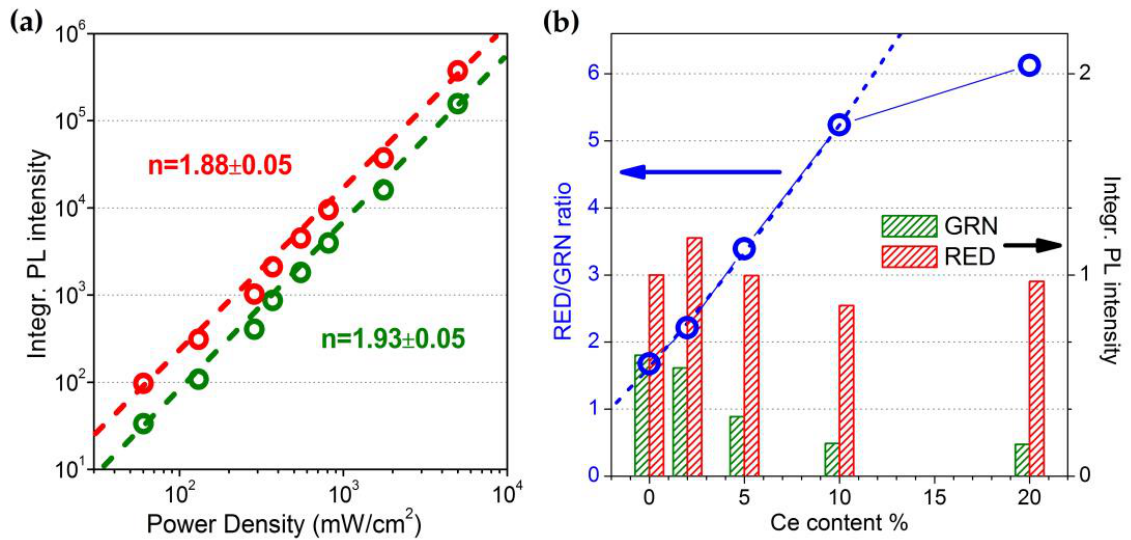
Figure 4. ( a ) Log – log plot of the integrated UCPL intensity of GRN and RED emissions vs. 980 nm pumping power density; the order n of the UC processes corresponds to the slope of the linear fit (dashed lines) of the experimental data; the measurements were performed on Ce_10 sample. ( b ) Bar graphs of GRN and RED emission intensity and scatter + line plot (hollow blue dots and solid blue line) of RED-to-GRN intensity ratio vs. Ce 3+ content; the dashed line corresponds to a parabolic fit of the intensity ratio, considering the data in Ce 3+ content range of 0 – 10 at.%.